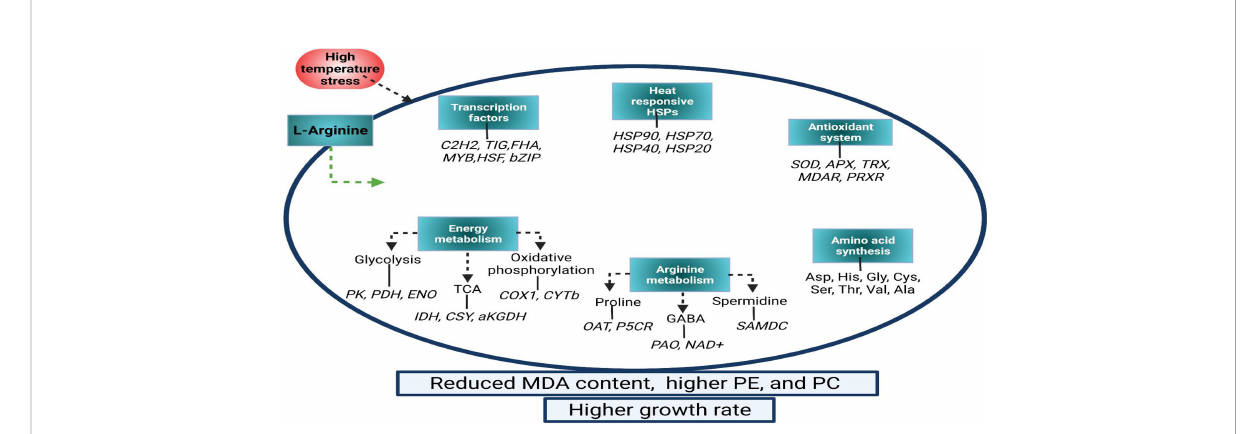
FIGURE 3 A model diagram for Arg-induced high temperature tolerance in G. lemaneiformis attributed to physiological and transcriptional alterations. PE, phycoerythrin; PC, phycocyanin; MDA, malondialdehyde; SOD, superoxide dismutase; APX, ascorbate peroxidase; TRX, thioredoxin; MDAR, monodehydroascorbate reductase; PRXR, peroxiredoxins; OAT, ornithine – oxo-acid transaminase; P5CR, pyrroline-5-carboxylate reductase; SAMDC, S-adenosylmethionine decarboxylase; GABA, g -aminobutyric acid; PAO, polyamine oxidases; NAD+, aldehyde dehydrogenase; Asp, aspartate; His, histidine; Gly, glycine; Cys, cystine; Ser, serine; Thr, threonine; Val, valine; Ala, Alanine; PK, pyruvate kinase; PDH, pyruvate dehydrogenase; ENO, enolase; TCA, tricarboxylic acid; IDH, isocitrate dehydrogenase; CSY, citrate synthase; a KGDH, 2-oxoglutarate dehydrogenase (Zhang et al.,